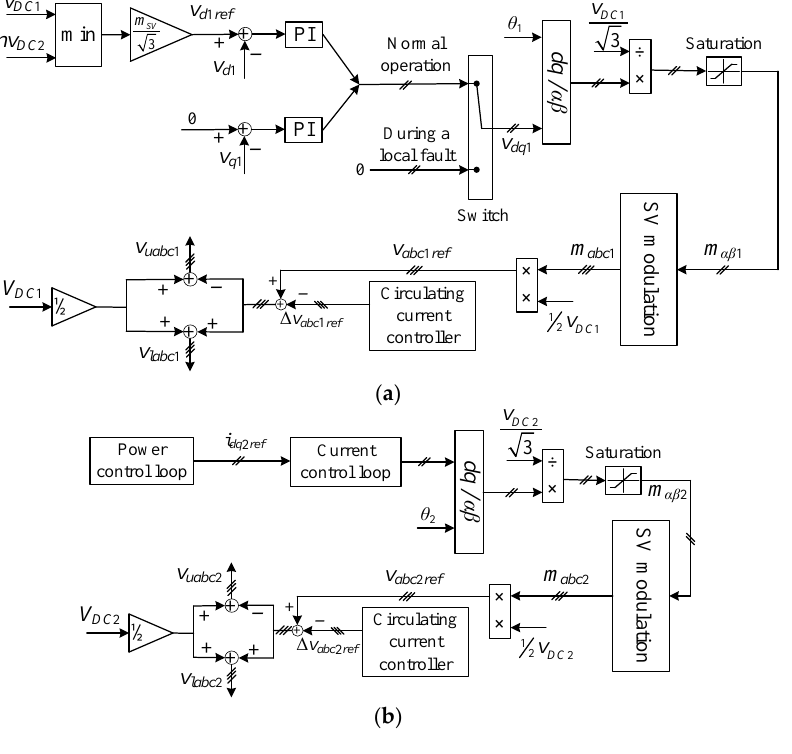
Figure 2. Proposed control strategy of the DC/DC converter: ( a ) AC voltage control; ( b ) power control. PI: Proportional–integral; SV: Space-vector.